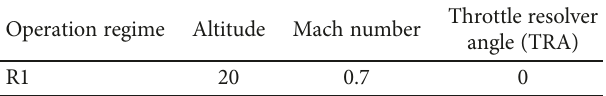
Table 2: Operating regime of the aircraft